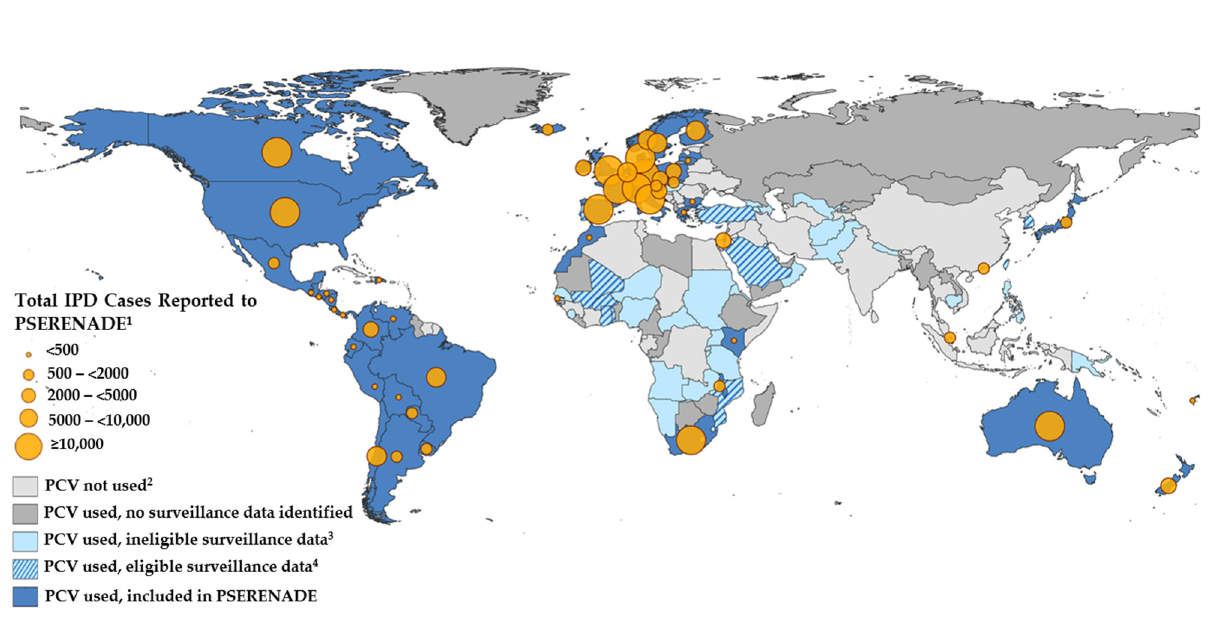
Figure 1. Availability of IPD surveillance data for countries with universal recommendations for PCV in the infant immunization program. 1 Cases from multiple surveillance sites within the same country were aggregated. 2 PCV not universally introduced into the routine infant immunization program by 2018 (includes India which began sub-national introduction in 2017). 3 IPD surveillance data did not meet PSERENADE data collection eligibility criteria (Box 1). 4 IPD surveillance data met data collection eligibility criteria but did not participate in PSERENADE.